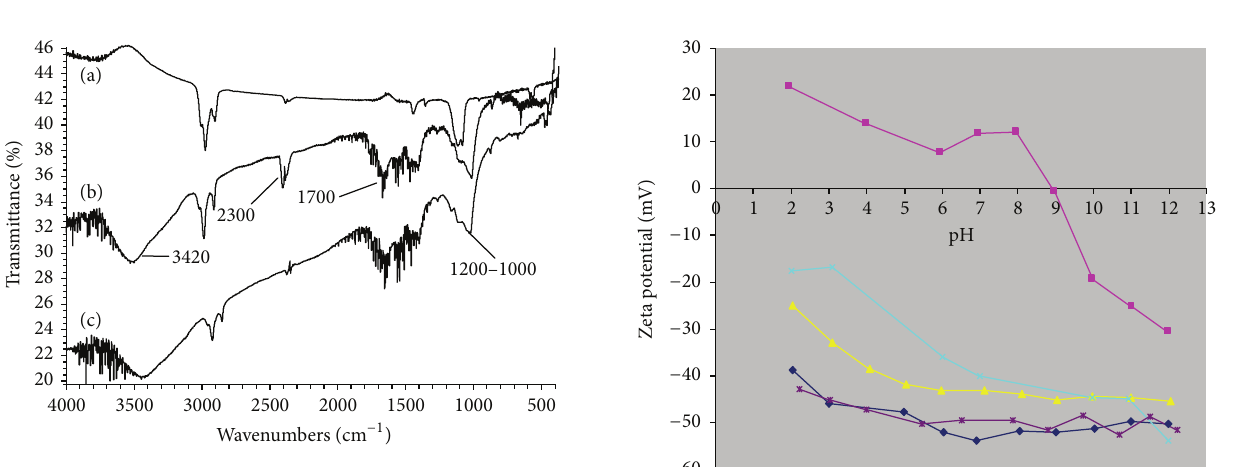
Figure 1: IR Spectra of purified and oxidized MWCNTs with (b) HNO 3 and (c) NaOCl. Figure 2: Zeta potentials of purified ( ◼ ) and oxidized MWCNTs